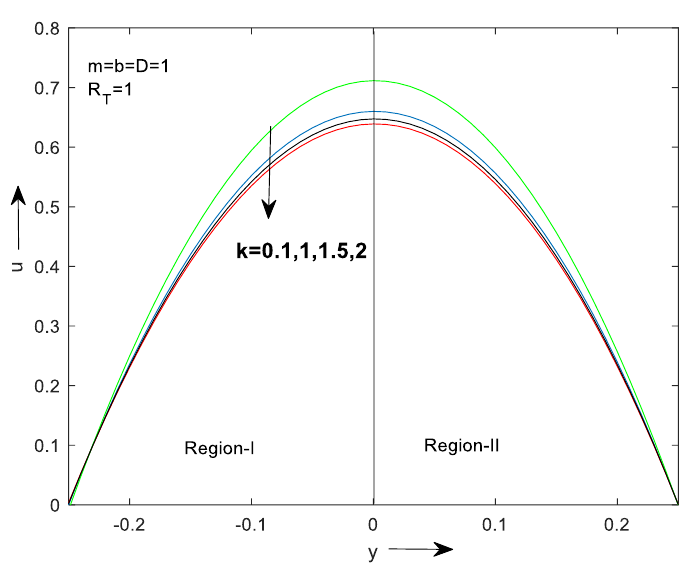
Fig. 7a. Velocity profile for different values of k